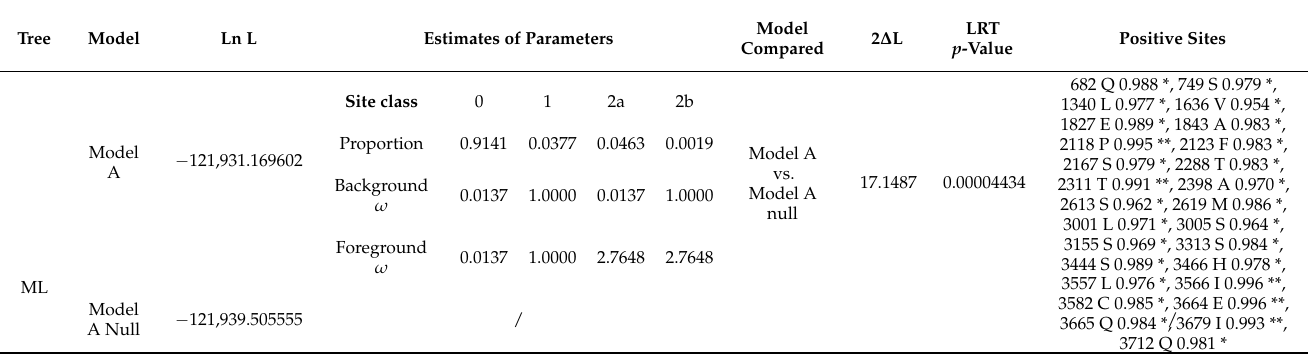
encoding genes, with an additional six positive selection sites situated in other domains of corresponding genes (Table 5, Figure S5, Supplementary Materials). Table 4. Positive selection analysis of mitochondrial protein-coding genes based on the branch-site model. Tree